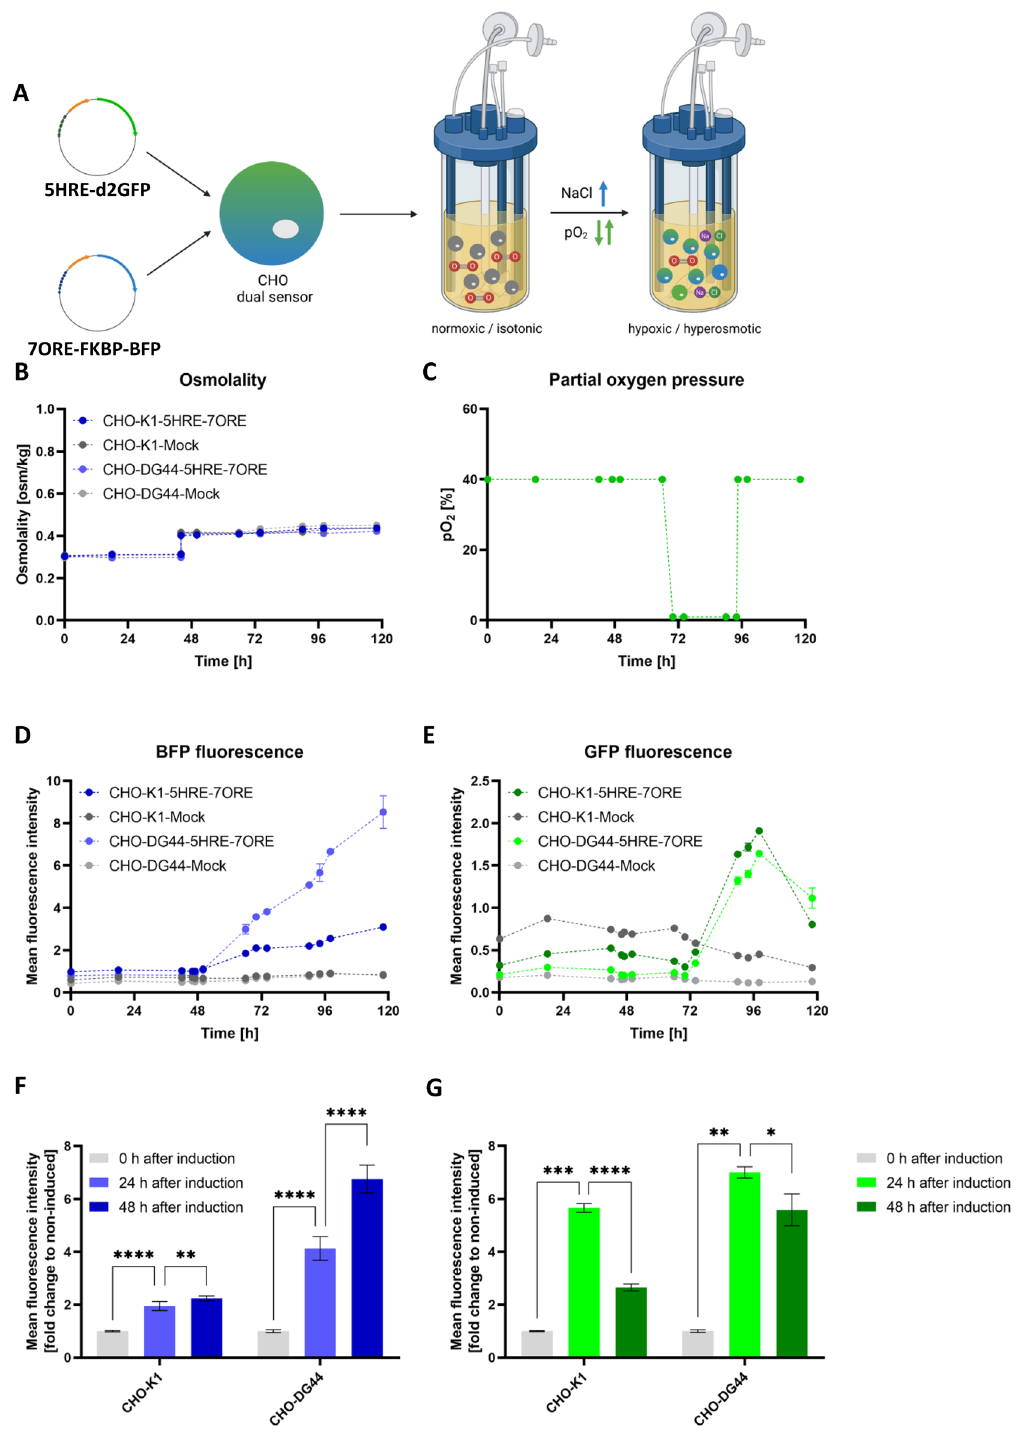
Figure 3. Batch fermentation of dual sensor cell lines under hypoxic and hyperosmotic conditions. ( A ) Schematic experimental setup. ( B ) Osmolality during batch fermentation. ( C ) pO 2 concentration during batch fermentation. ( D , E ) Flow cytometric analysis of CHO-K1 and -DG44 cells during batch fermentation expressing FKBP-BFP (D) and d2GFP ( E ). ( F ‚ G ) Relative fold-change of FKBP-BFP ( F ) or d2GFP ( G ) mean fluorescence against the mock control cell line during batch